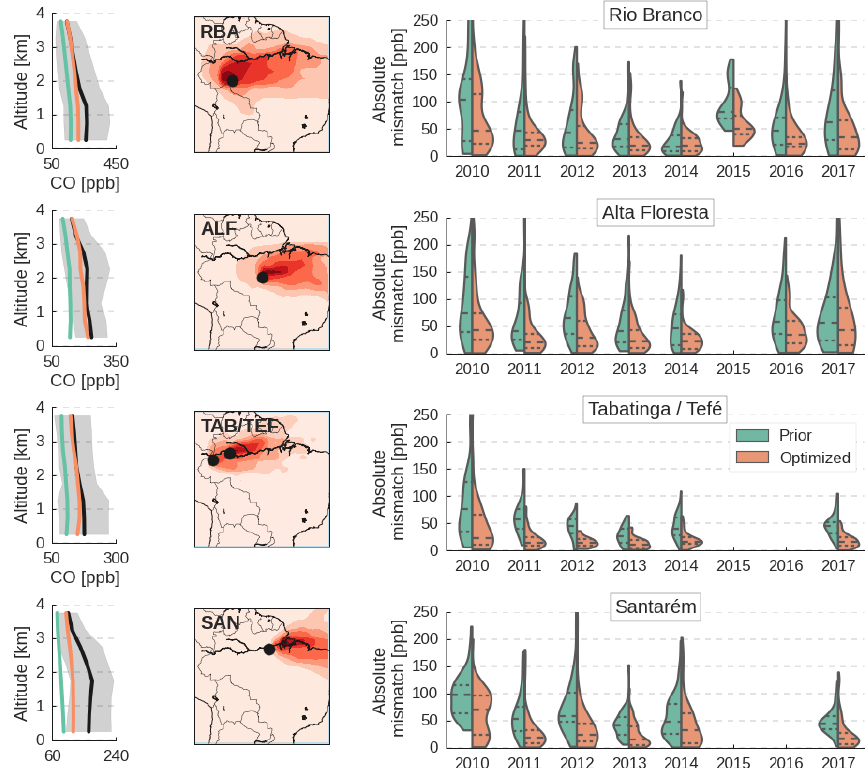
Figure 6. Comparison between simulated and observed aircraft profiles over five sites in the Amazon. Profiles sampled over Tabatinga and Tefé are combined, as they represent similar air masses and have complementary temporal coverage (Tabatinga up to 2013 and Tefé after 2013). The profiles cover the 2010–2017 period, and we have included only profiles sampled between August and November. The left column presents the time-averaged (2010–2017) simulated (prior in green; posterior in orange) and observed (black) aircraft profiles, binned in 500m intervals. The grey shaded areas show 1 standard deviation of the variability between the individual observed aircraft profiles. The centre column shows maps of the influenced area of each site or each site combination. Black dots indicate site locations, and the red area indicates the origin of air at the site location. Red areas are proportional to the logarithm of the number of back trajectories that originate at the sampling location and altitude, and then pass through a grid cell, as determined from simulations in the Hybrid Single-Particle Lagrangian Integrated Trajectory (HYSPLIT) model (Stein et al., 2015). Further details are provided in Gatti et al. (2010). Back trajectories from the Lagrangian grid in the HYSPLIT model were interpolated to the TM5 1 ◦ × 1 ◦ grid. The right column presents violin plots of the absolute difference between observed and simulated aircraft samples of CO, in a simulation with GFAS-optimized (green) and in a simulation with MOPITT-optimized biomass burning emissions (orange). The dashed lines inside each violin indicate the median and the two inner quartiles.